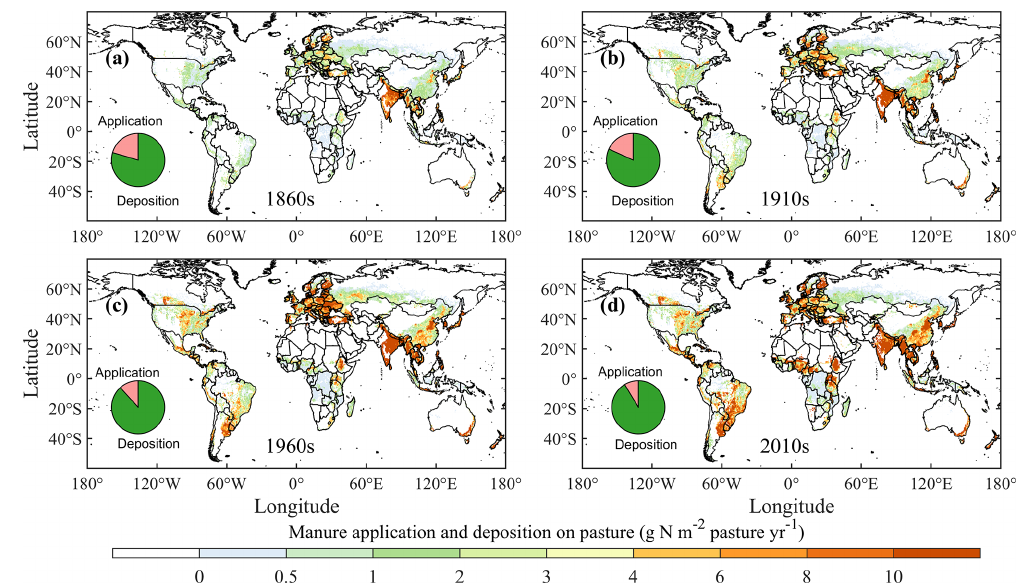
Figure 9. Spatial patterns of manure N application and deposition on pasture in the 1860s, 1910s, 1960s, and 2010s.